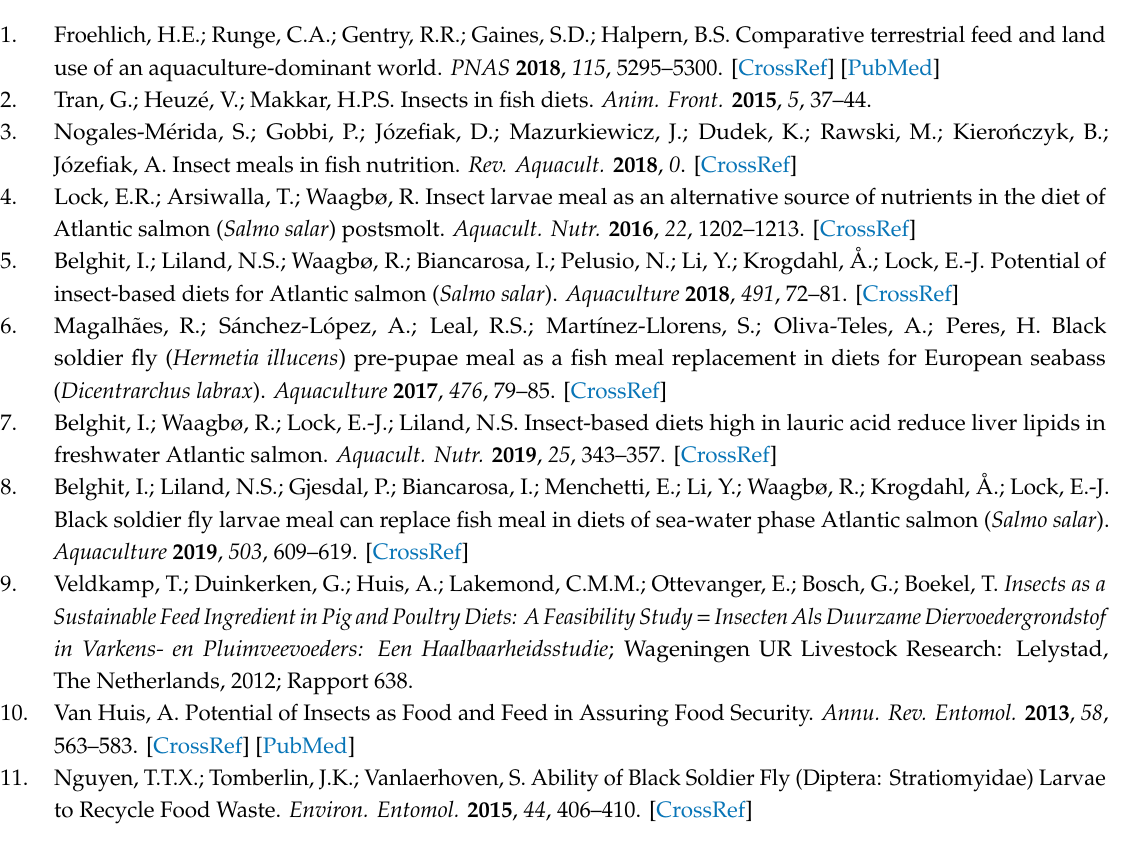
Figure S1: A representative LC chromatogram of IM sample, Table S1: Amino acid composition of 18 IM samples in mg / g wet weight, Table S2: Protein (Pr) and protein yield (Py) quantified using two di ff erent protein extraction protocols; Table S3: Insect specific peptides identified using two di ff erent protein extraction protocols in laboratories A and B, Table S4: Insect specific proteins identified using two di ff erent protein extraction protocols in laboratories A and B; Table S5: Insect specific peptides commonly identified using two di ff erent protein extraction protocols in laboratories A and B, Table S6: Insect specific proteins commonly identified using two di ff erent protein extraction protocols in laboratories A and